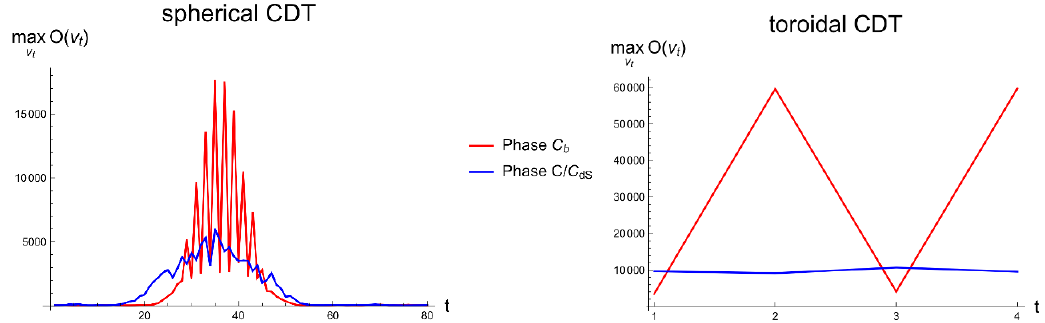
Figure 10 . Phase diagram of CDT with toroidal spatial topology ( (cid:6) = T 3 ) for (cid:22) N and t tot = 4. Points denote the actual numerical simulations. The measured phase transitions are marked by solid lines with error bars denoted by shaded areas of the same color. The error bars for the C (cid:0) C b transition are due to the observed hysteresis of the measured order parameters (see section 6 for discussion), the error bars for the other phase transitions are purely due to the resolution of the measurement grid. Dashed black lines are extrapolations of the measured phase transition lines. All four distinct phases of geometry can be identi(cid:12)ed. Phase A is observed for large values of (cid:20) 0 (orange points), phase B for small values of (cid:1) (black points), phase C b for small (cid:20) 0 and medium (cid:1) (blue points), and phase C for small (cid:20) 0 and large (cid:1) (green points).